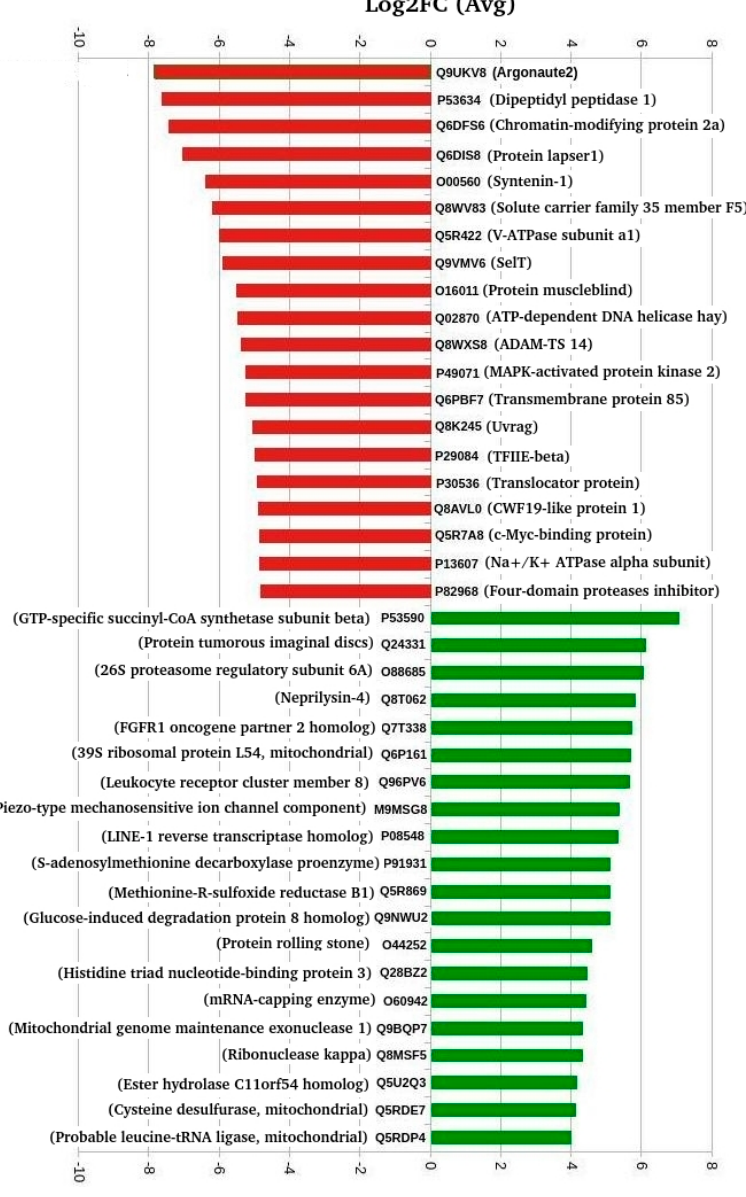
Figure 3. Top 20 up- and downregulated differentially expressed transcripts.